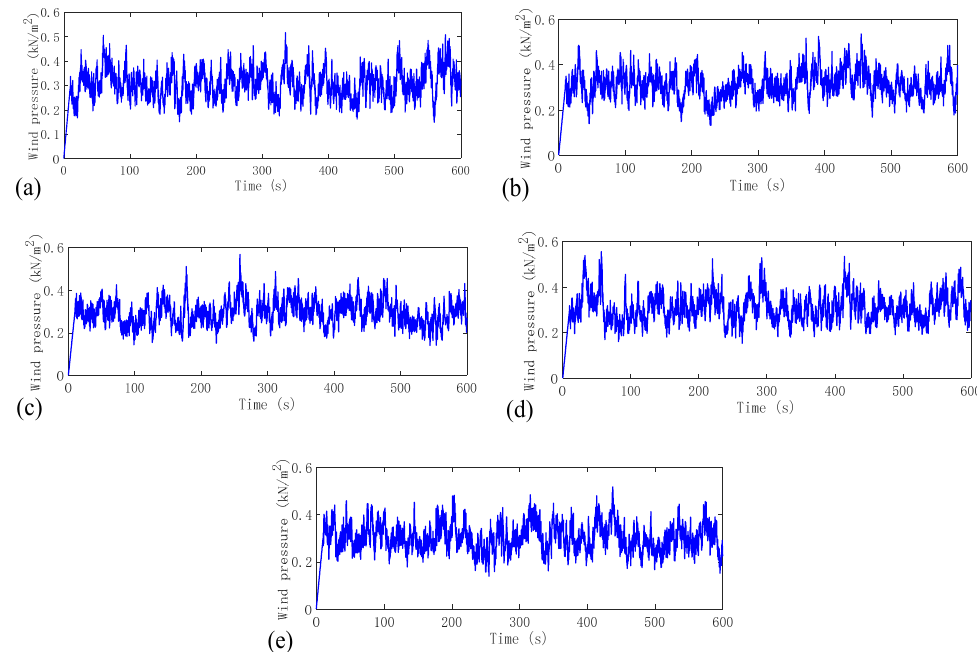
Figure 17. Generated wind pressure time histories: ( a ) wind 01; ( b ) wind 02; ( c ) wind 03; ( d ) wind 04; and ( e ) wind 05.